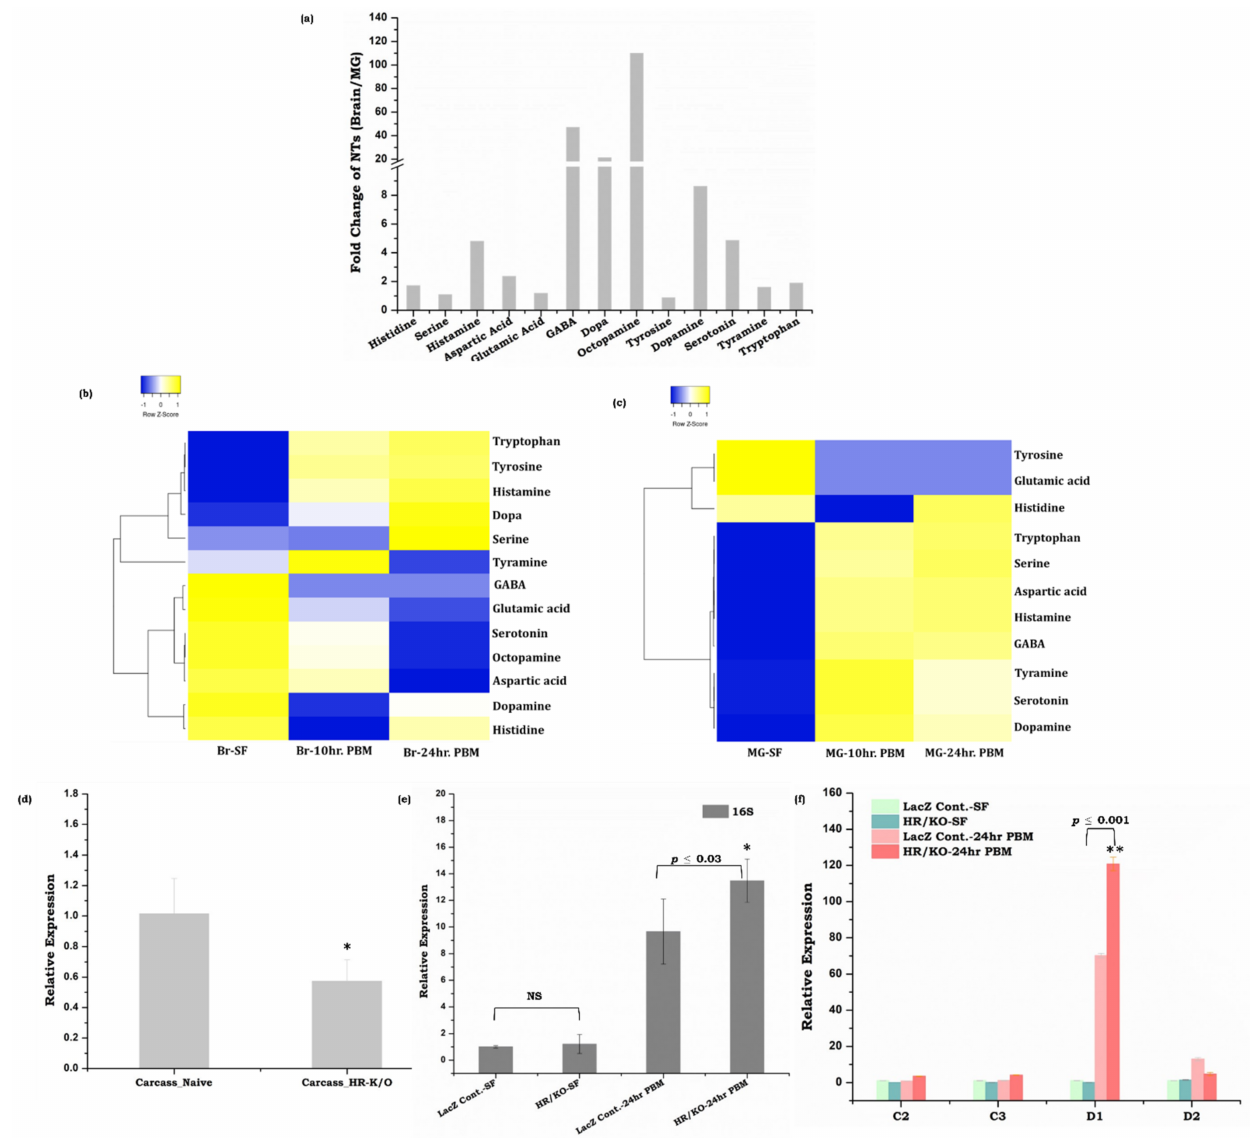
Figure 4. Gut–Brain–Axis (GBA) communication and neurotransmitter (NT) estimation in mosquito An. culicifacies . ( a ) Comparative analysis of NT abundance in the naïve mosquitoes’ brain and midgut; ( b ) Heatmap showing the alteration of neurotransmitters level in mosquito brain tissue. NT levels were measured by LC-MS from the brains of naïve (sugar-fed) and blood-fed females (10 and 24 h PBM) ( n = 65, N = 2). Statistically significant differences in the amount of metabolites were tested by p -values ( p ≤ 0.005) that are deduced by two-way ANOVA and Tukey’s test; ( c ) Heatmap of neurotransmitters levels of mosquito gut tissue that vary during the metabolic switch. NT levels were measured by LC-MS from the gut of naïve (sugar-fed) and blood-fed females (10 and 24 h PBM) ( n = 50, N = 2). Statistically significant differences in the amount of metabolites were tested by p -values ( p ≤ 0.005) that are deduced by two-way ANOVA and Tukey’s test. ( n = number of mosquitoes from which the respective tissue was dissected and pooled for each independent experiment; N = number of biological replicates); ( d ) AcHR silencing validation in the carcass of An. culicifacies mosquitoes ( n = 10, N = 2) ( p ≤ 0.01) ( p ≤ 0.05 is indicated as ‘*’). ( e ) Relative expression of 16S transcripts in control and HR knockdown mosquitoes. ( f ) Transcriptional response of immune genes in control vs HR knockdown mosquitoes during naïve sugar-fed and blood-fed conditions. p ≤ 0.005 is indicated as ‘**’, p ≤ 0.05 is indicated as ‘*’. C1: Cecropin 1, C2: Cecropin 2, D1: Defensin 1, D2: Defensin 2. Statistically significant differences for the silencing experiments are deduced by Students’ t